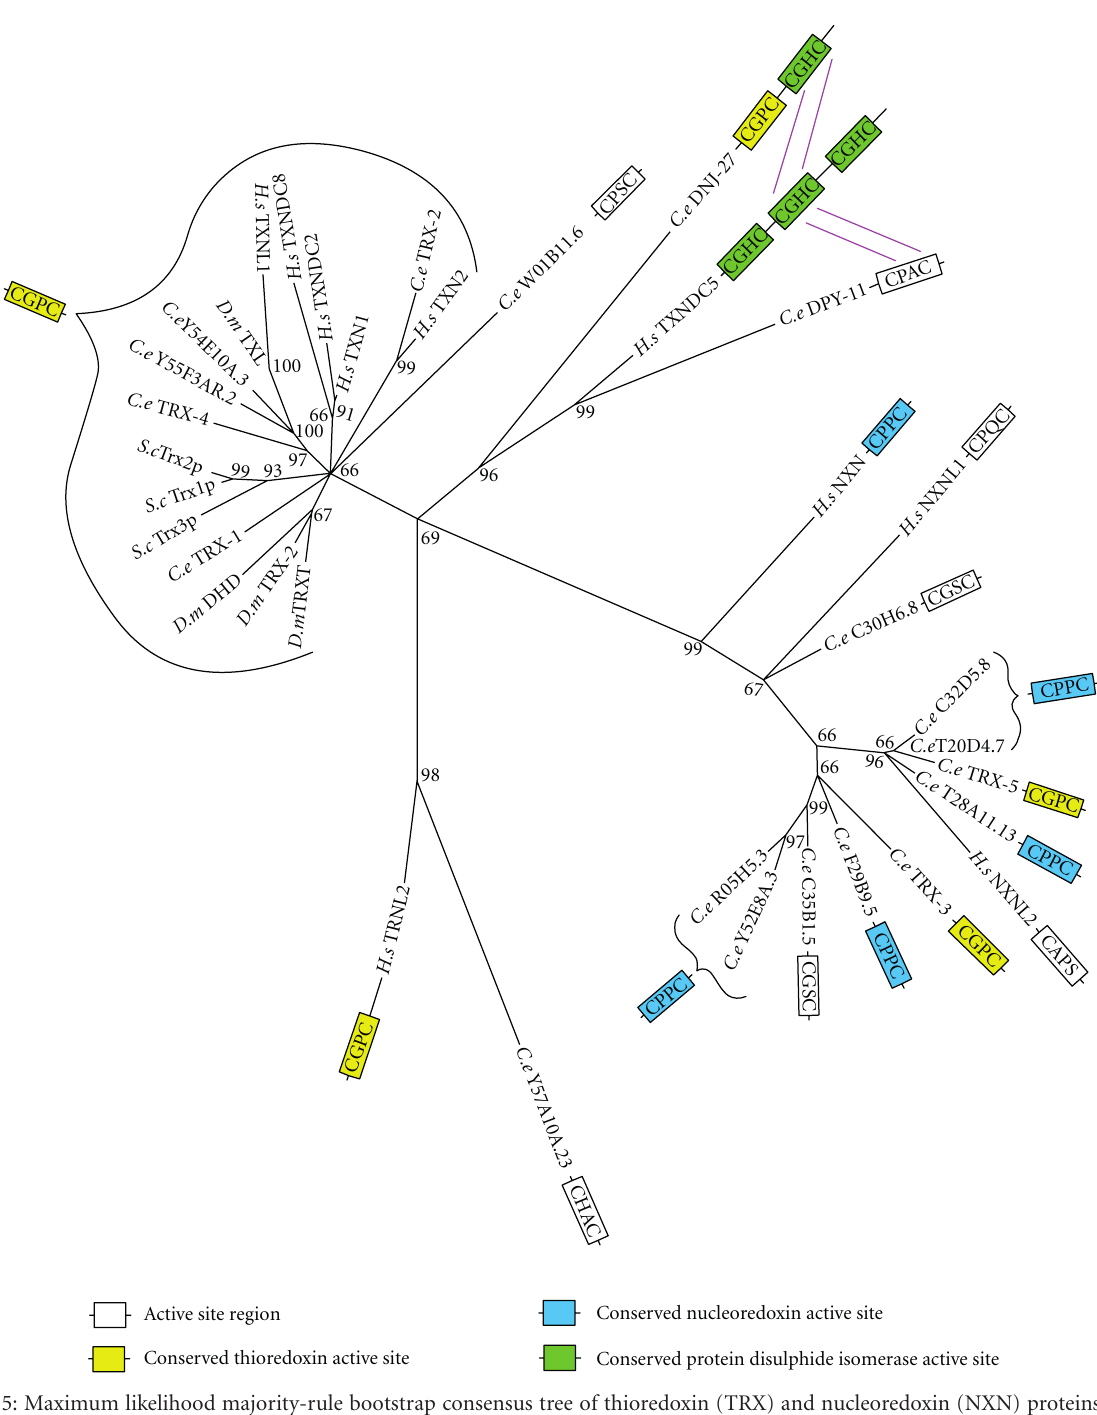
Figure 5: Maximum likelihood majority-rule bootstrap consensus tree of thioredoxin (TRX) and nucleoredoxin (NXN) proteins. A blast (blastp) search of known Homo sapiens ( H.s ), Saccharomyces cerevisiae ( S.c ), and Drosophila melanogaster ( D.m ) proteins was undertaken to identify all the homologs within these three species. The proteins from these species were then blasted against Caenorhabditis elegans ( C.e ) to identify homologues in the Genbank database. Identified sequences with significant expected value ( ≤∼ 1E − 10) were used to generate a multiple sequence alignment (MSA) via ClustalW 2.1. The MSAs were then trimmed and used to produce a maximum likelihood majority- rule bootstrap consensus tree inferred from 1000 replicates via Mega 5.10. Proteins with sequences greater that ∼ 350aa that were more closely related to other families discussed in this paper, such as GRX or PDI, were removed from this analysis. Some proteins fit equally well with TRX and TRX-related families, for example, DPY11 can be found in both the TRX and protein disulfide isomerase (PDI)